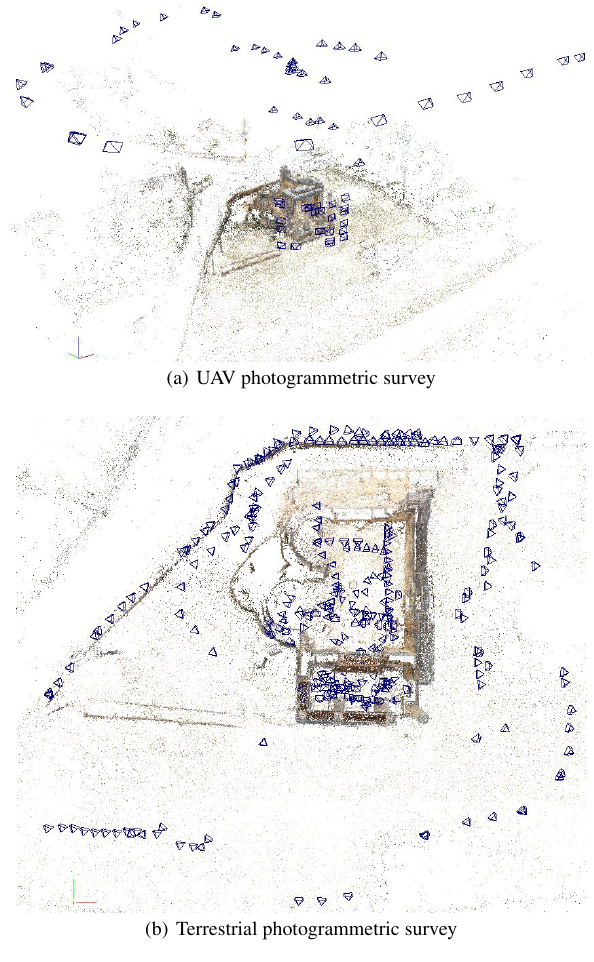
Figure 4. Pose of the images (shown as blue pyramids) acquired during (a) the UAV and (b) the terrestrial photogrammetric surveys, together with the sparse point cloud obtained by processing simultaneously both datasets.